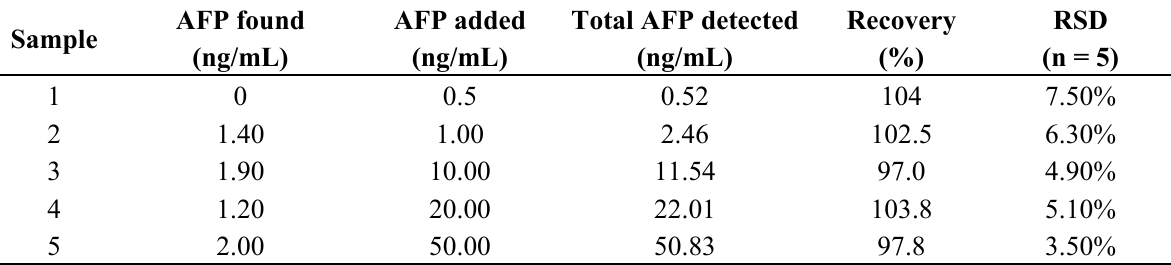
Table 1. Recovery of AFP in human serum